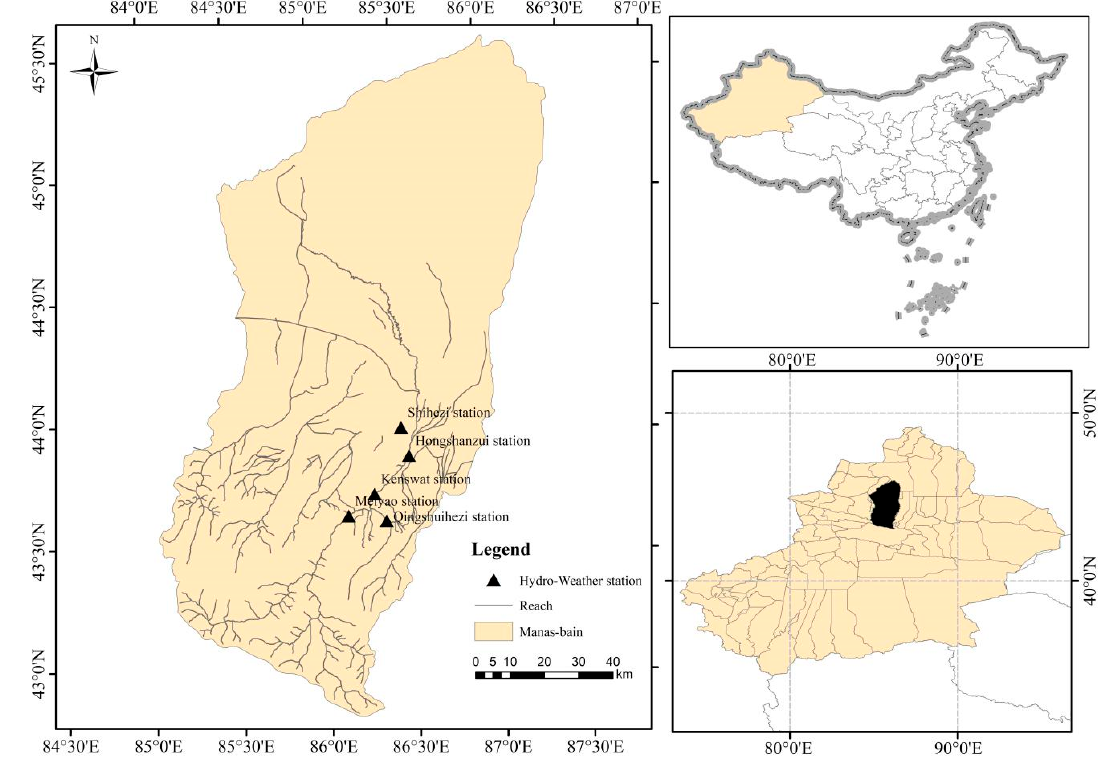
Figure 1. Map of the study area with the administrative division of the Manas River Basin.